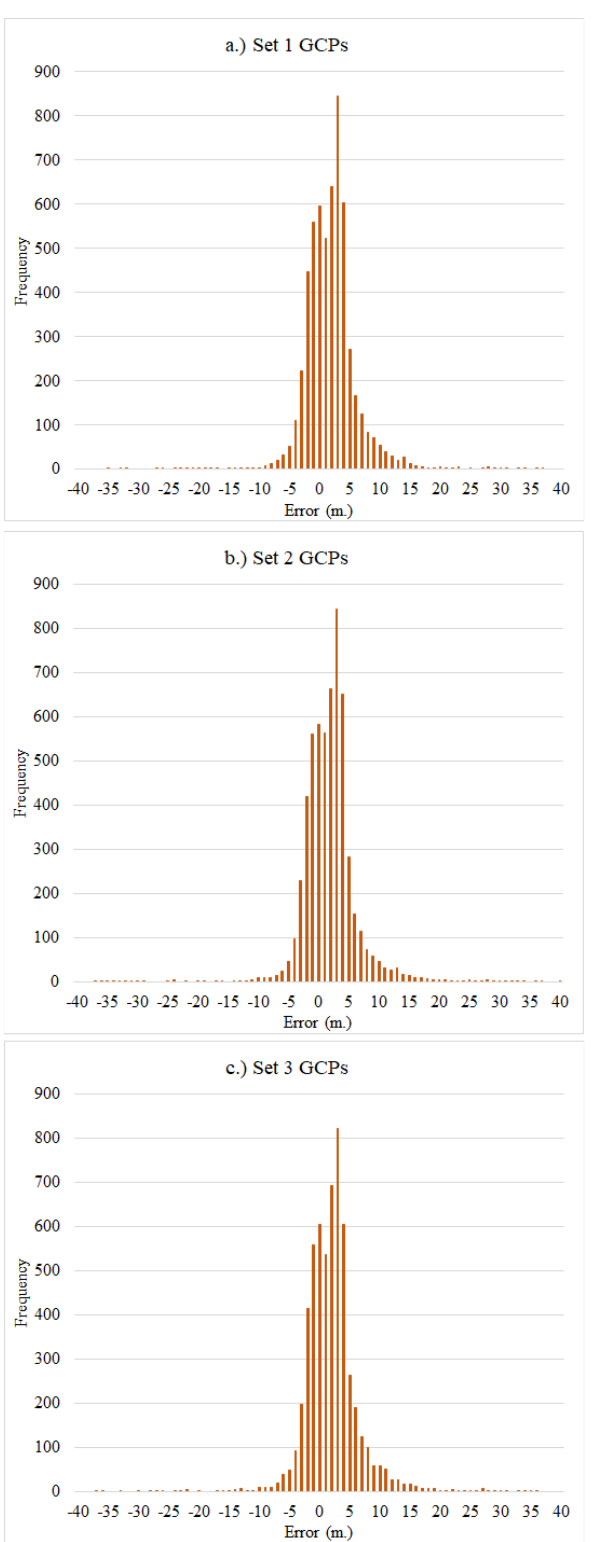
Table 4. Country-level statistics of the elevation differences between FABDEM and the three sets of the GCPs (unit: